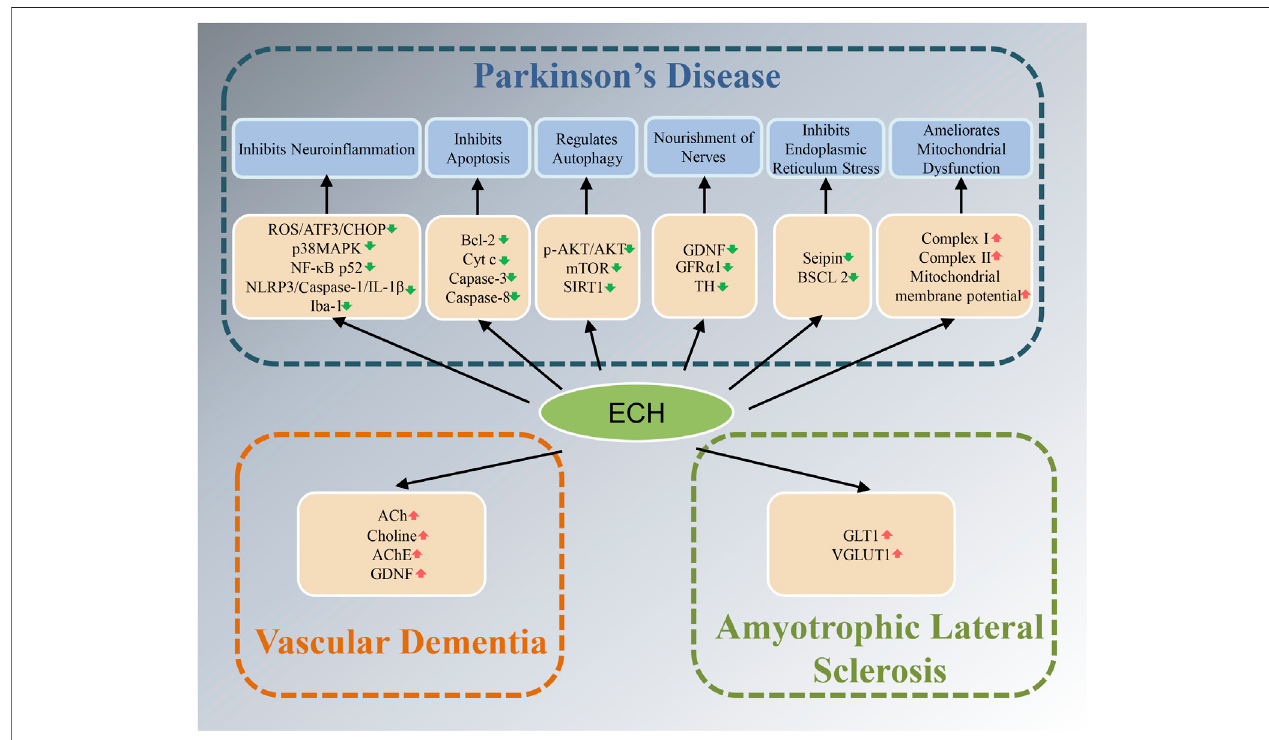
FIGURE 3 | Diagram with neuroprotective mechanisms of Echinacoside (ECH) in Parkinson ’ s disease (PD), amyotrophic lateral sclerosis (ALS), and vascular dementia (VD). ECH can improve neurodegenerative diseases by improving oxidative stress, neuroin fl ammation, apoptosis, autophagy, nourishment of nerves, and mitochondrial dysfunction signaling